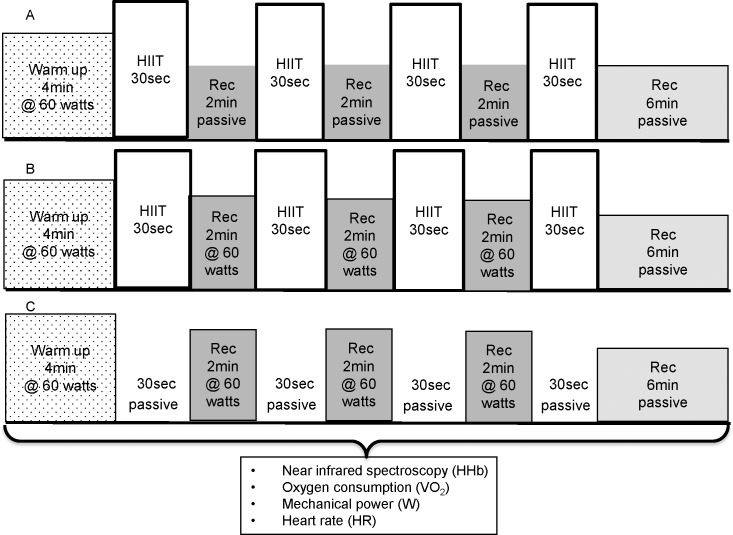
The structure and timing of measurements of the three conditions.(A) HIITPASS. (B) HIITACT. (C) REC.